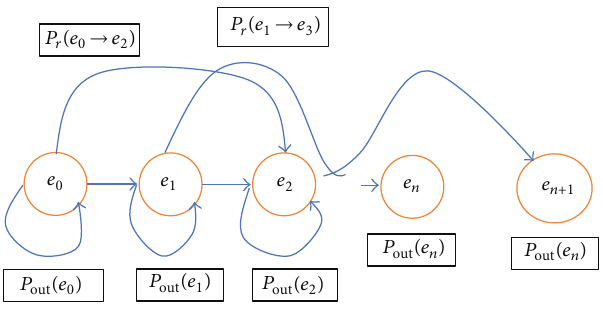
Figure 3: Energy state